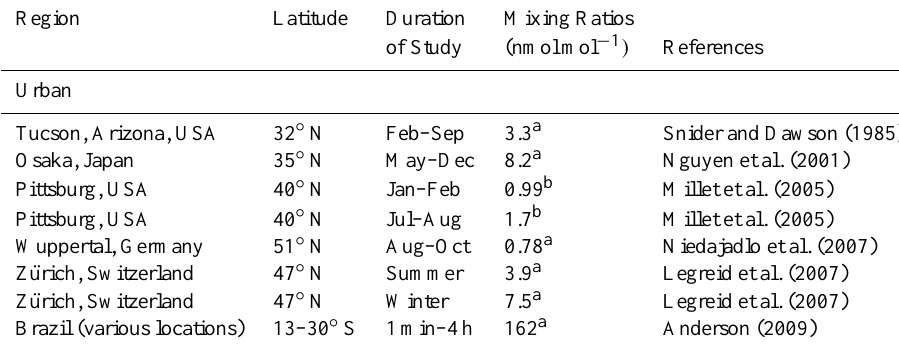
Table 2b. Mixing ratios of ethanol in the urban continental boundary